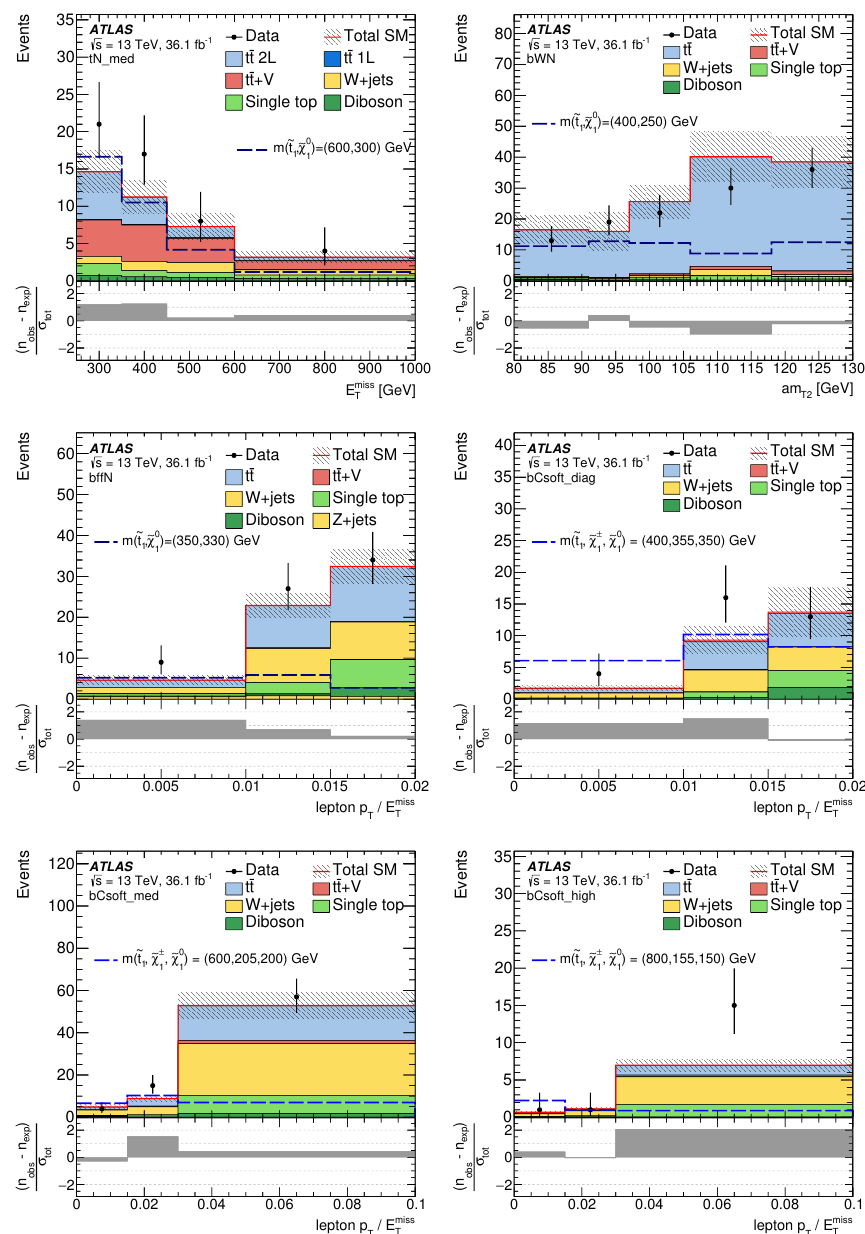
Figure 19 . Kinematic distributions for the shape-(cid:12)t analyses: (top left) E miss in tN med , (top right) T am T2 in bWN , (middle left) p ‘ / E miss in bffN , (middle right) p ‘ / E miss in bCsoft diag , (bottom left) T T T T p ‘ / E miss in bCsoft med , and (bottom right) p ‘ / E miss in bCsoft high . The full event selection T T T T in the corresponding signal region is applied, except for the requirement that is imposed on the variable being plotted. The predicted SM backgrounds are scaled with the normalisation factors obtained from the corresponding control regions in tables 23 and 24. The hatched area around the total SM prediction includes statistical and experimental uncertainties. The last bin contains over(cid:13)ows. Benchmark signal models are overlaid for comparison. The bottom panels show the di(cid:11)erence between data and the predicted SM background divided by the total uncertainty ( (cid:27) tot